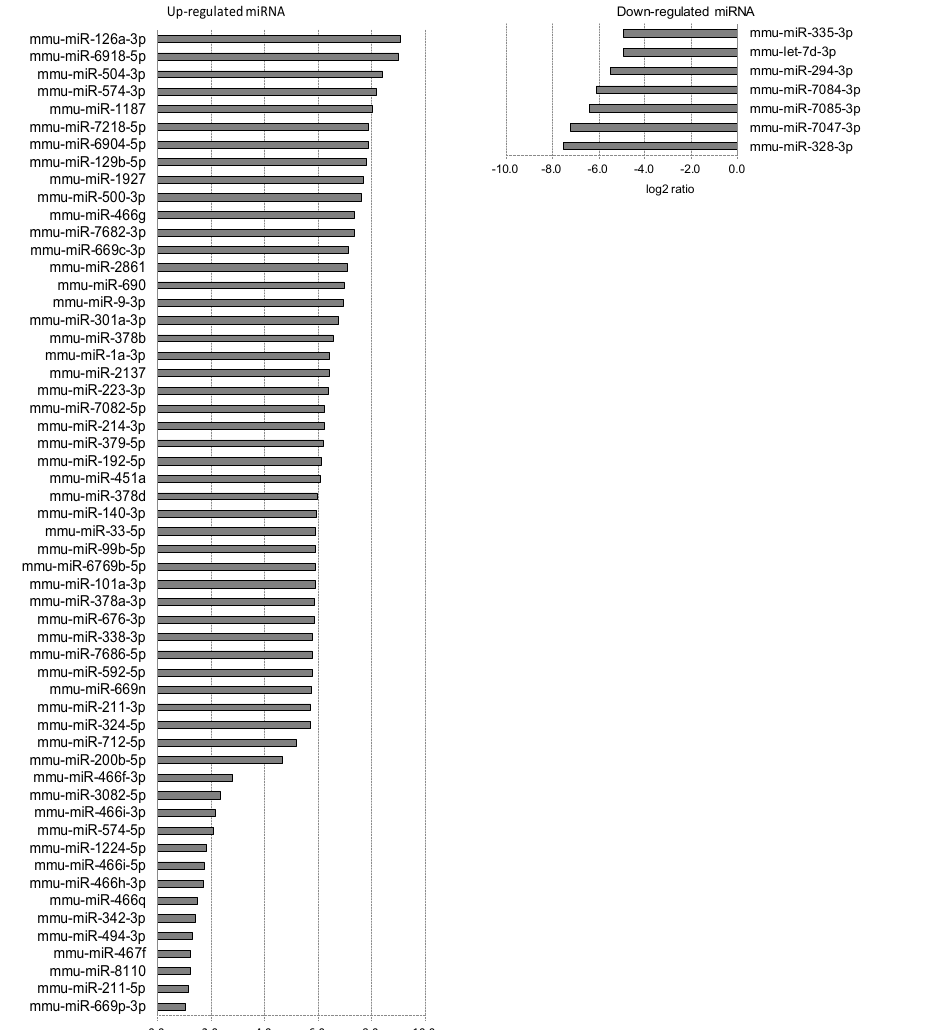
0.0 Figure 4. Corneal miRNAs affected by myopia induction. The corneal miRNAs whose expression was affected by myopia induction are listed as upregulated ( left ) and downregulated ( right ).